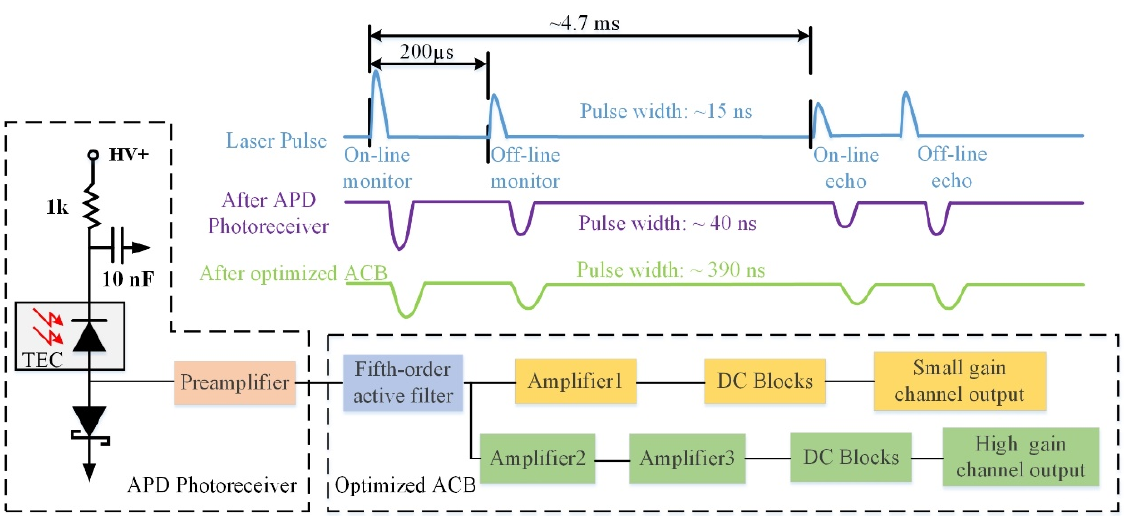
Figure 2. The timing relationship of return signals and schematic diagram of 1572 nm detector for the spaceborne IPDA LIDAR. TEC: Thermo electric cooler. DC: Direct current.